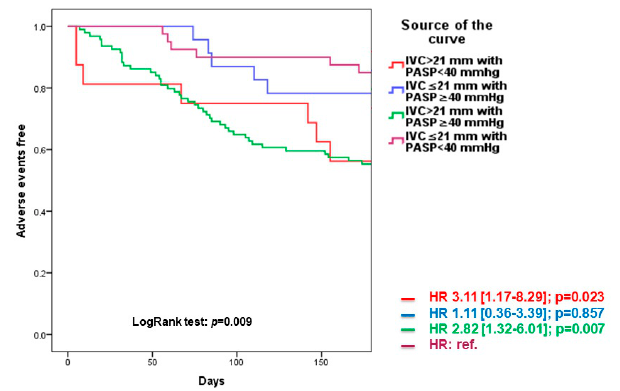
Figure 2. Adverse events rate according to ICV and PASP values.